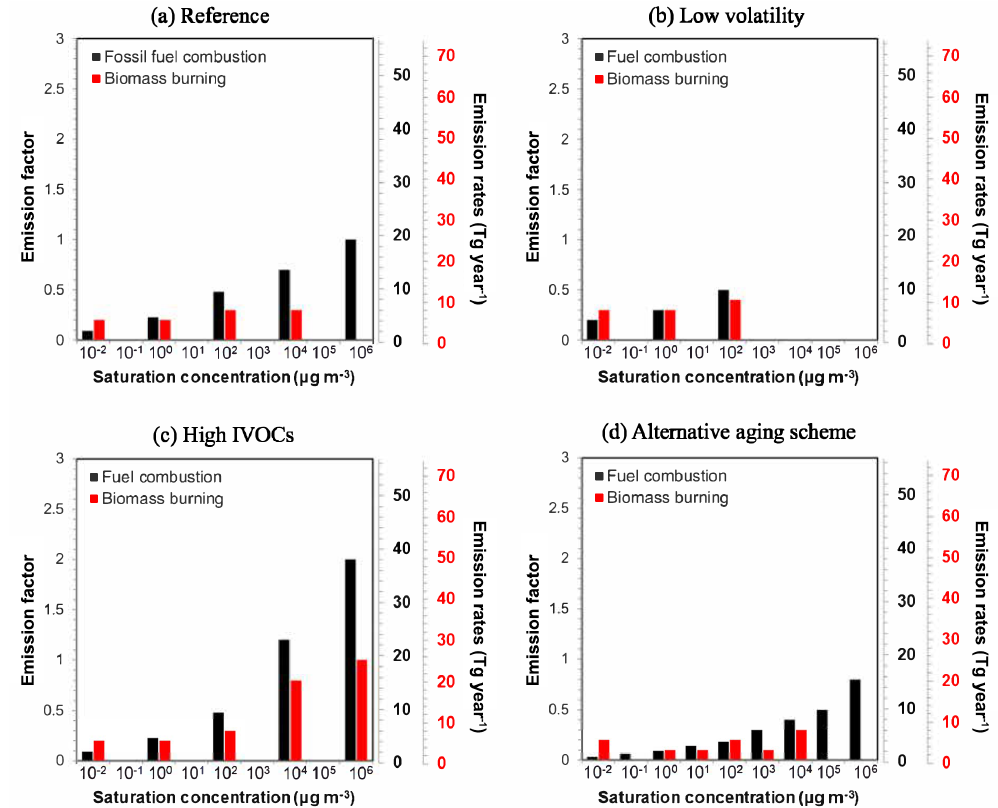
Figure 2. Volatility distribution for fuel combustion (black) and biomass burning OA (red) for the (a) reference, (b) low-volatility, (c) high IVOCs, and (d) alternative aging scheme simulations. The reference emission factors are from Robinson et al. (2007) for f POA (anthro- pogenic POA from fossil fuel and biofuel combustion) and May et al. (2013) for bbPOA (natural POA from open biomass burning) emissions. The emission rates of f POA and bbPOA are also shown on the right